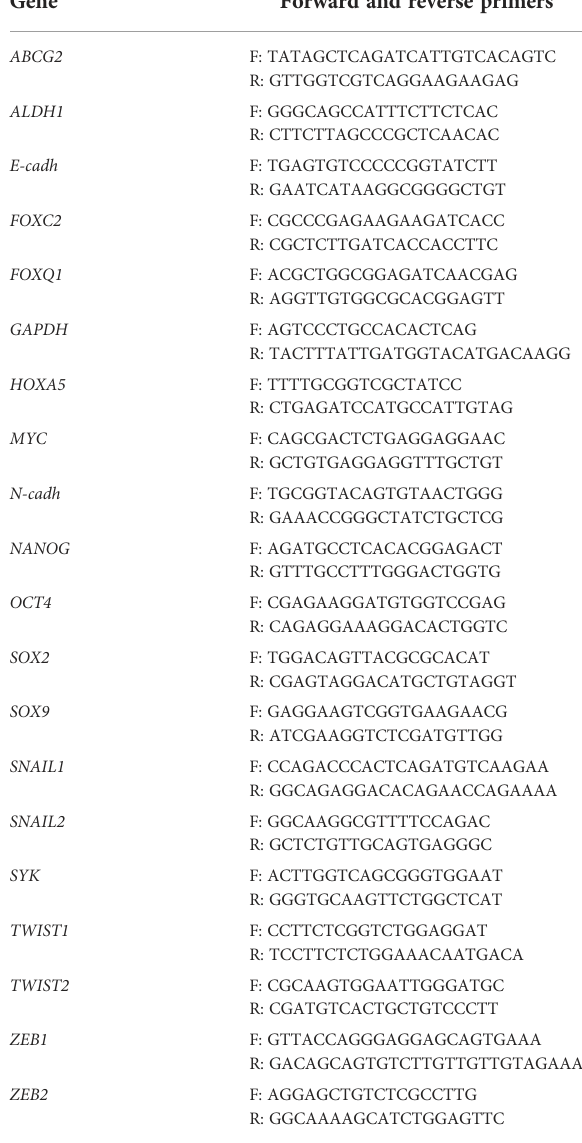
TABLE 1 Primers used for RT-qPCR